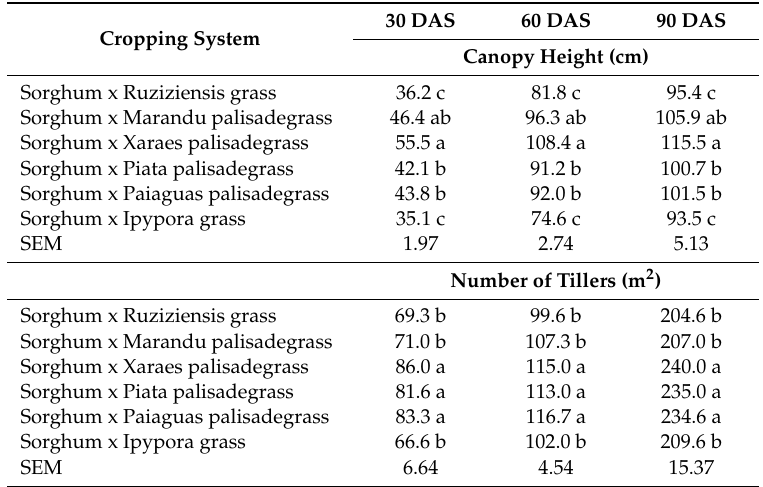
Table 3. Canopy height and number of tillers of forages of the genus Brachiaria intercropped with grain sorghum, evaluated at 30, 60, and 90 days after sowing (DAS).